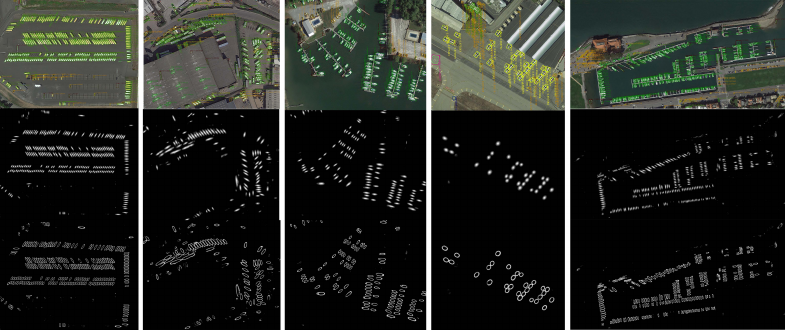
Figure 9. Detection results in whole images of DOTA testing set. All of them have high resolution and cover a large